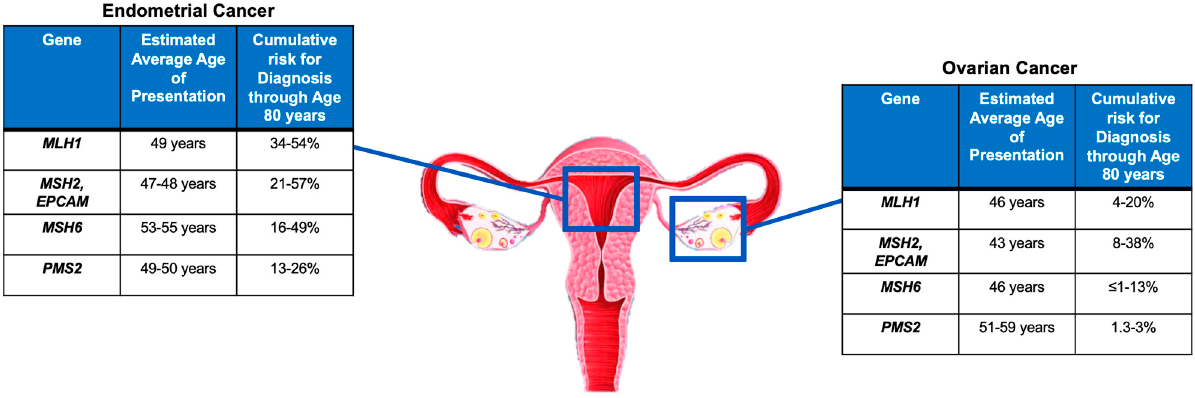
Figure 2. Gene-specific cancer risk and average age at diagnosis